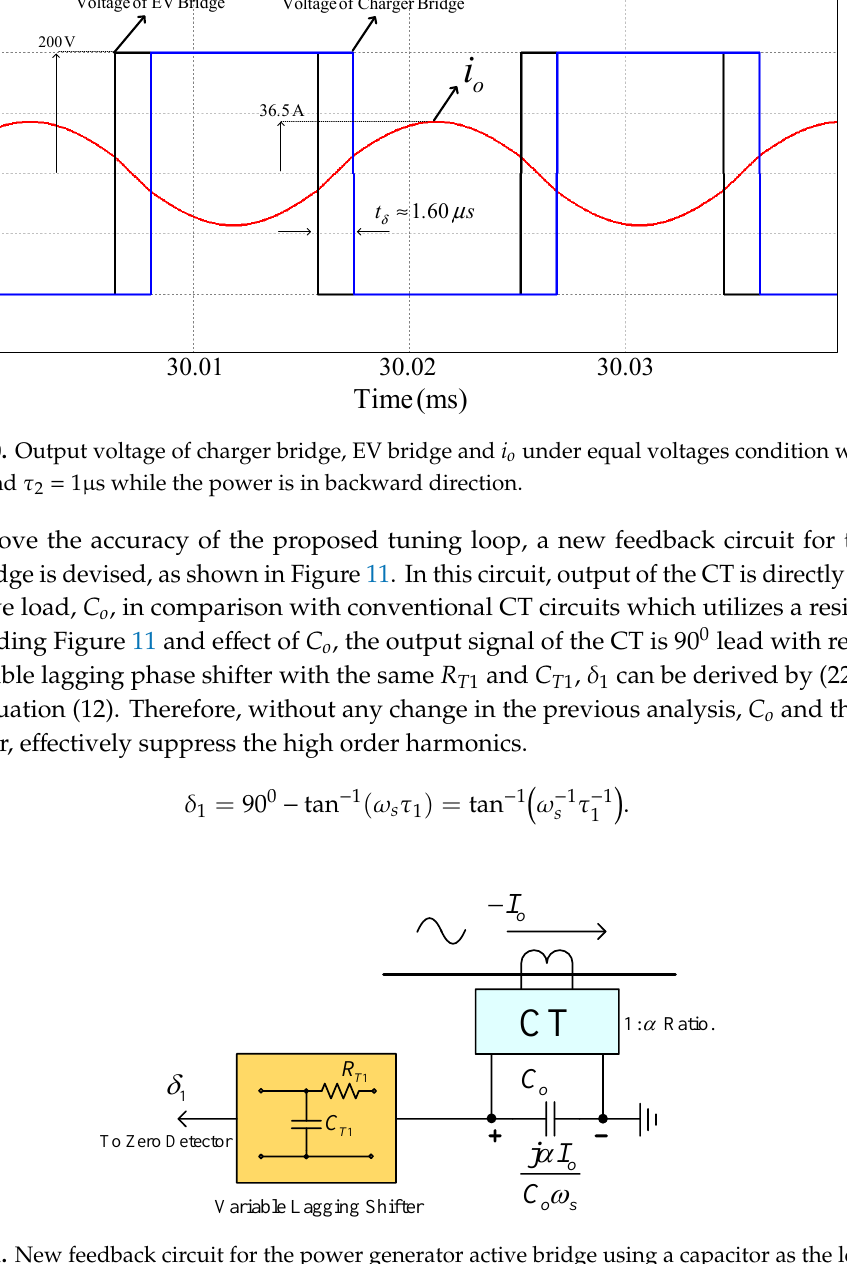
Figure 11. New feedback circuit for the power generator active bridge using a capacitor as the load of the current transformer (CT) and a variable lagging phase shifter.